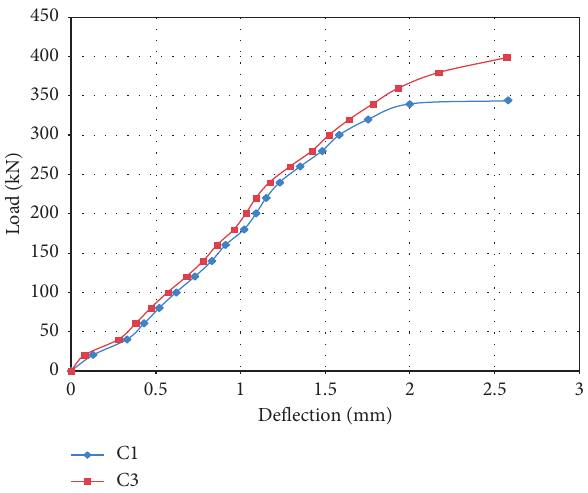
Figure 8: Load-deflection curve of corbels of 0% weight fractions of replacement aggregate for concrete strength 28.2 and 36.2MPa and a/d ratio 0.5.